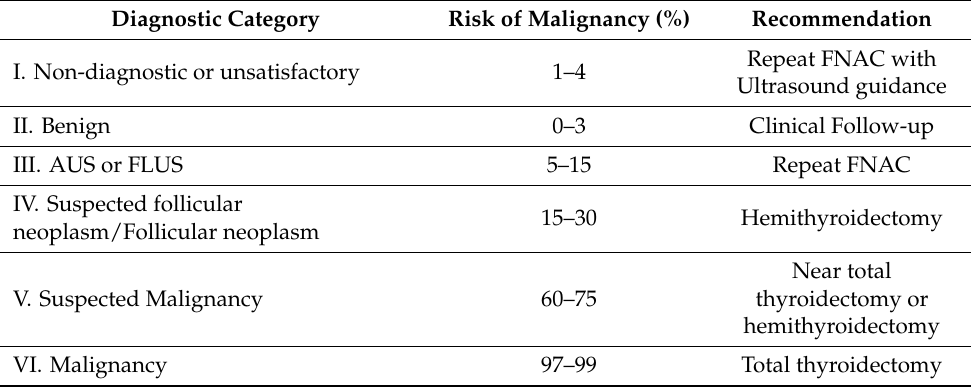
Table 1. The Bethesda System for Reporting Thyroid Cytopathology (TBSRTC) classification.